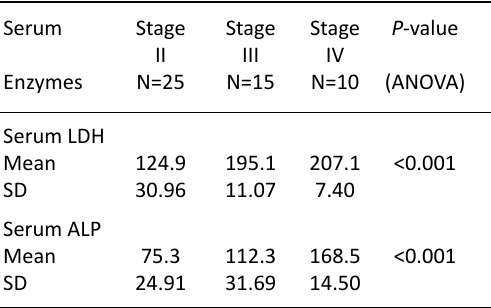
table 4. Correlation between LDH and ALP in CRC patients Serum enzymes Correlation